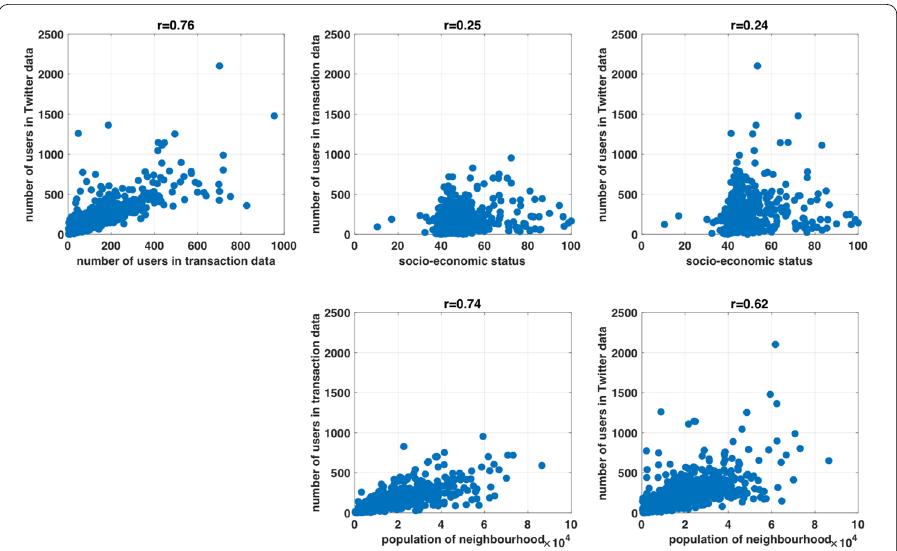
Figure 5 The relationship between the number of customers in the transaction data set, the number of users in the Twitter data set, and the neighborhood-level wealth, for the European metropolitan